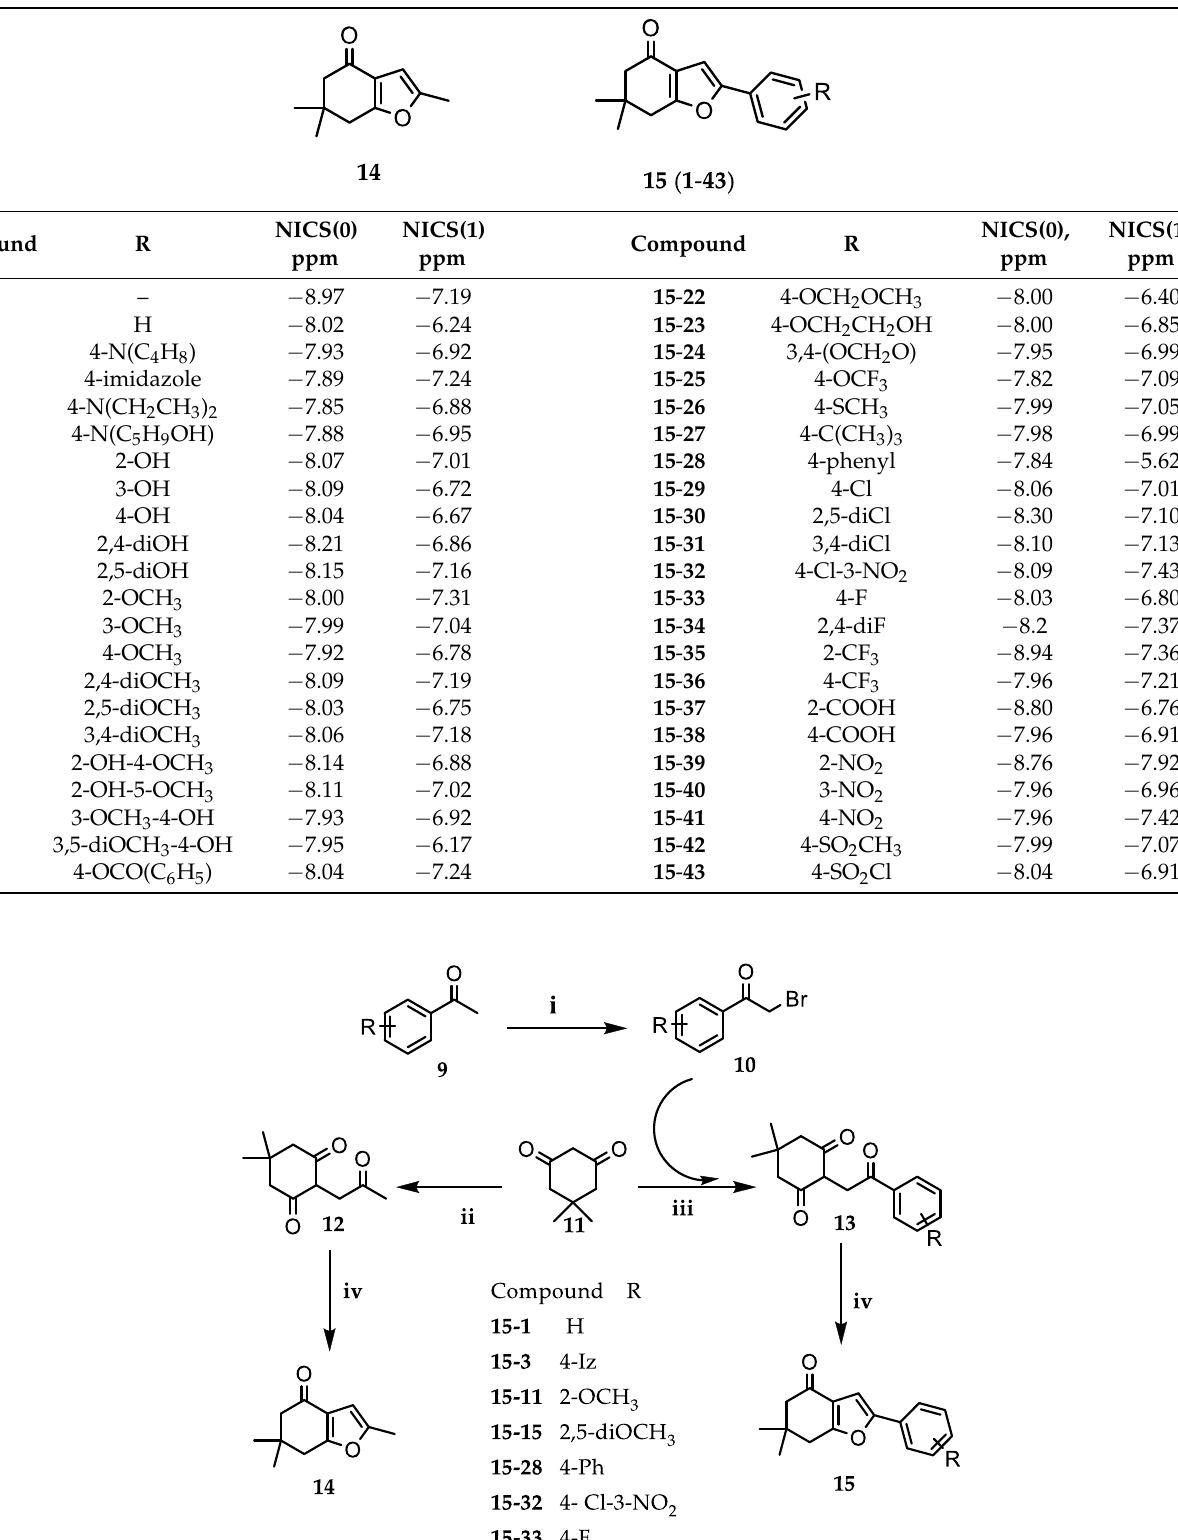
Table 4. NICS values for the 44 benzofuran-4-ones designed ( 14 , 15 - 1 to 15 - 43 ).